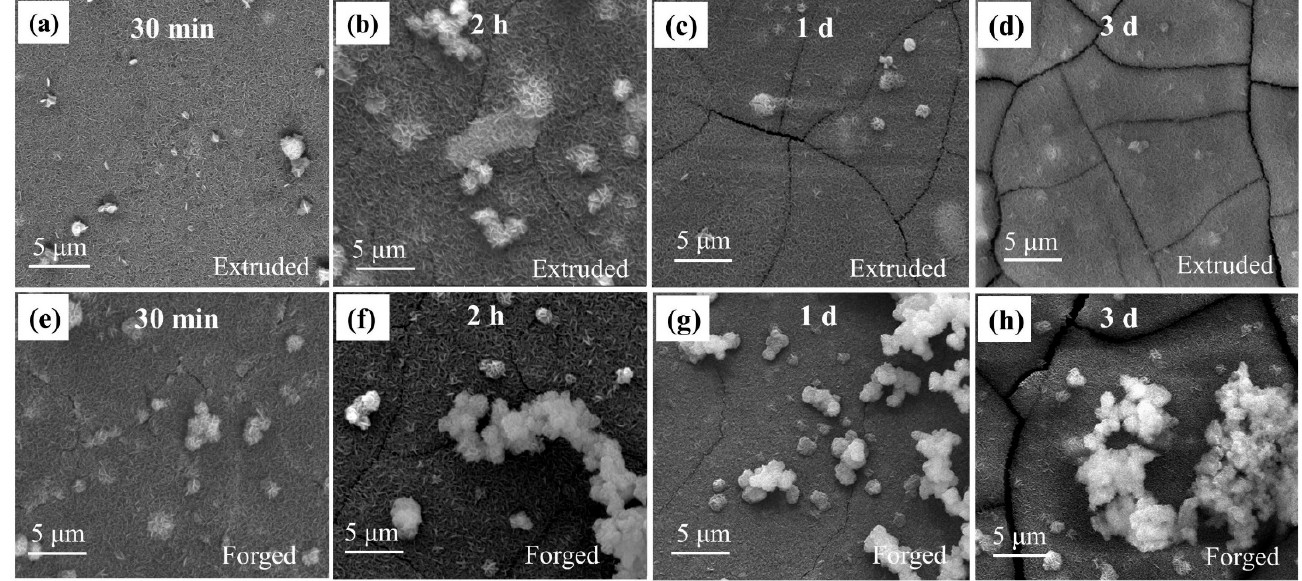
Figure 6. Surface morphologies of the ( a – d ) extruded and ( e – h ) forged WE43 alloys after immersion in 0.6 M NaCl solution for ( a , e ) 30 min, ( b , f ) 2 h, ( c , g ) 1 day, and ( d , h ) 3 days.